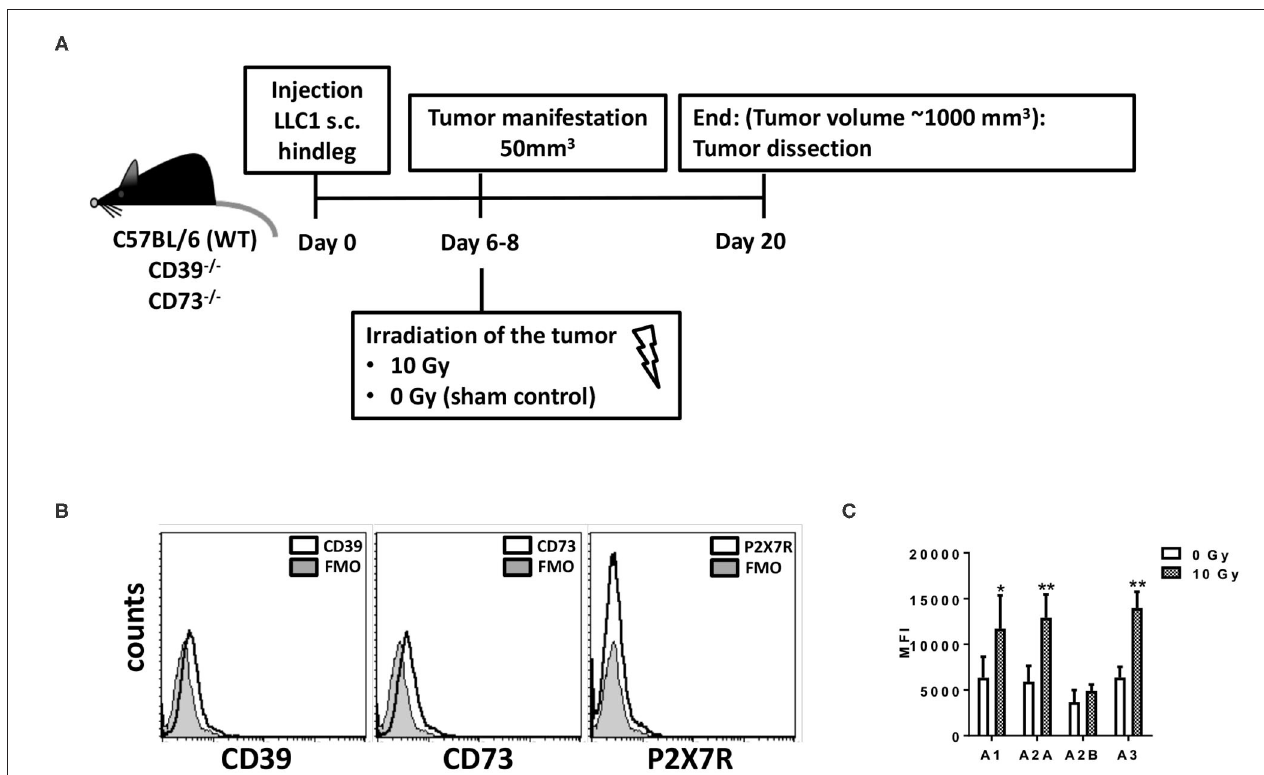
FIGURE 1 | LLC1 murine lung cancer cells are deficient for CD39, CD73, and P2X7 but express the four Ado receptors. For in vivo experiments mouse syngeneic tumors were generated by subcutaneous injection of 0.5 × 10 6 LLC1 cells into the hindlimb of C57BL/6 (WT), CD73 − / − , and CD39 − / − mice. On days 6–8 after tumor manifestation, tumors were irradiated with 0Gy (sham) or 10Gy. Tumors were dissected at day 20 or when the tumor volume reached 1,000 mm 3 . (A) Schematic depiction of the experimental setup. (B,C) LLC1 cells were stained against (B) CD39, CD73, P2X7R; FMO = fluorescence minus one) or (C) AdoR- A1, A2A, A2B, and A3 and were further analyzed by flow cytometry (data show means ± SD; * P ≤ 0.05, ** P ≤ 0.01 by one-way ANOVA followed by post hoc Newman–Keuls test).